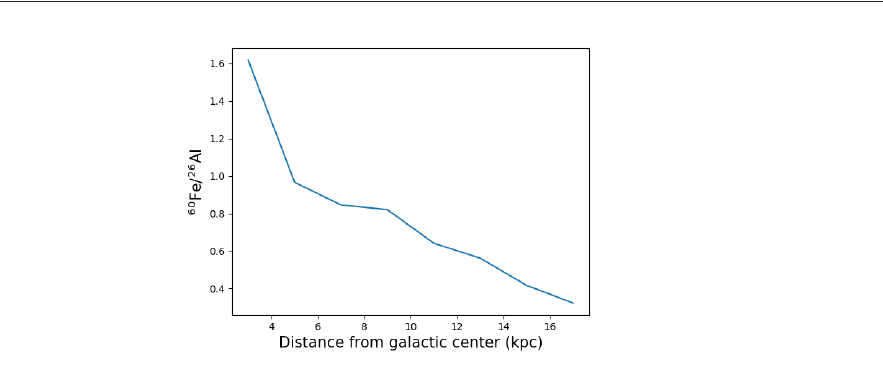
Figure 3. The ratio of absolute abundance of 60 Fe / 26 Al in the Galaxy for eight annular rings from 2-18